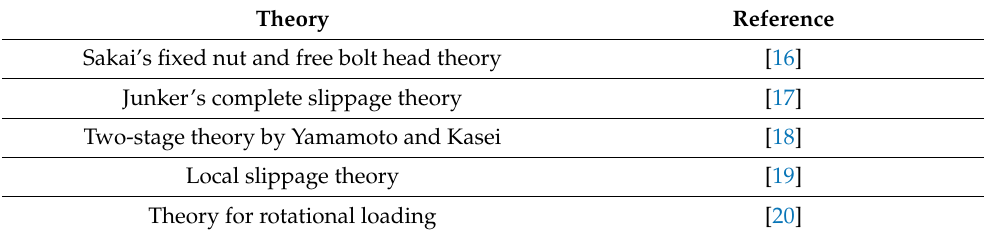
Table 2. Theories of loosening mechanisms presented by different